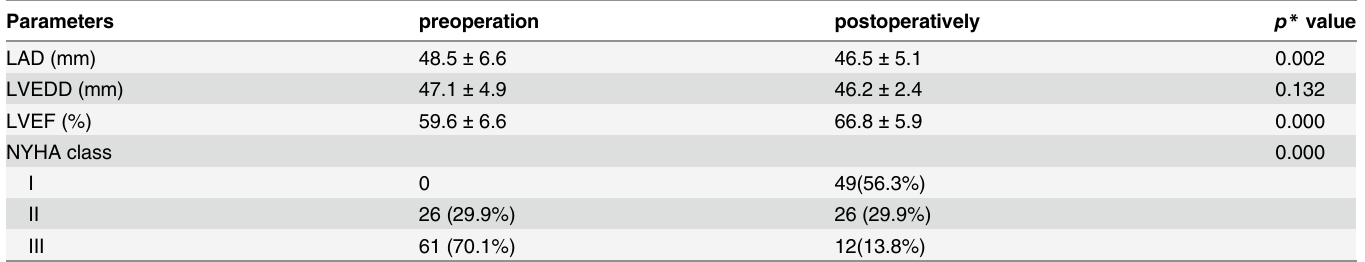
Table 4. Changes in echocardiographic parameters and NYHA class between preoperation and late postoperatively. Parameters